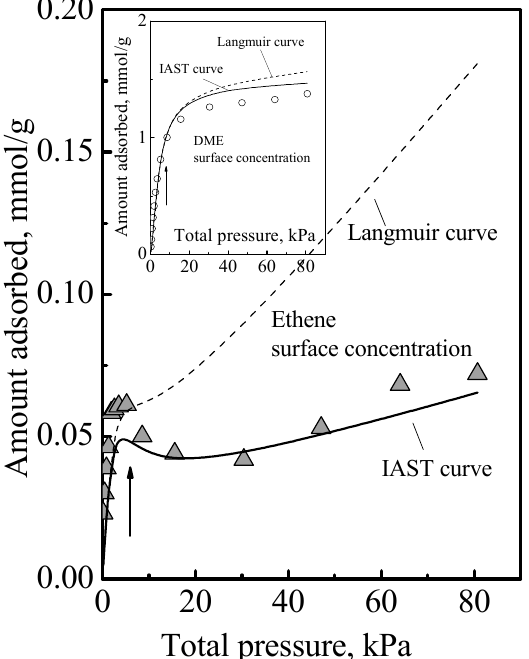
Figure 5. Surface concentration of ethene by adsorption from a 57:43 mol% DME-ethene gas mixture. The curves show the concentrations calculated using the multicomponent Langmuir isotherm and the IAST. The inset shows the corresponding surface concentration of DME. The arrow indicates the acid site density, which is 1 mmol/g.